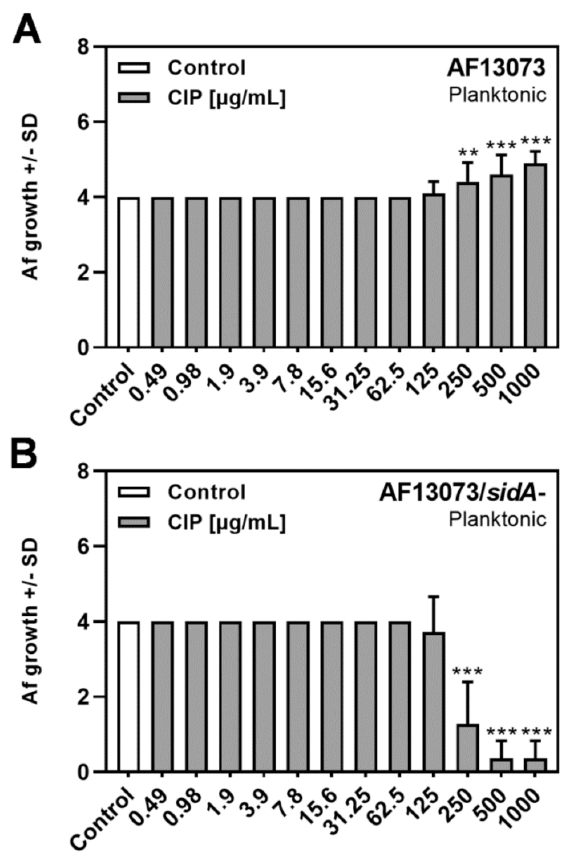
Figure 2. CIP induces A. fumigatus planktonic wildtype growth, but reduces planktonic growth of the siderophore-deficient mutant. CIP (final concentrations 0.49–1000 µ g/mL in RPMI 1640 medium, x-axis) was combined with ( A ) AF13073 or ( B ) AF13073/ sidA - conidia according to the CSLI guidelines for macro-dilution. The tubes were incubated at 37 ◦ C for 48 h. Fungal growth was measured visually, and rated as described in the Material and Methods section, with growth in control tubes assigned a ‘4’. The tubes with less growth were rated a number between 0 and 3, and for tubes with more growth than the control, a number 5 or 6, depending on relative amount of growth. Statistical analysis, 1-way ANOVA: two or three asterisks = p ≤ 0.01 or p ≤ 0.001, respectively. Comparison: RPMI (white bar) vs. all other bars (grey bars). A: n = 8–10; B: n =